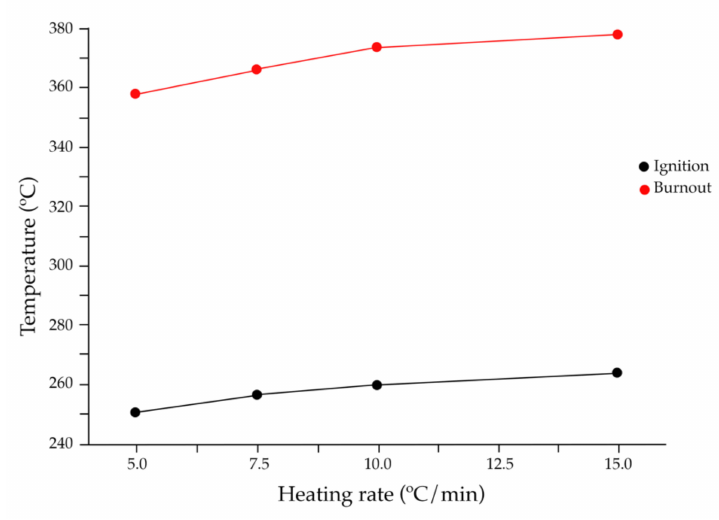
Figure 4. Ignition and burnout temperatures at IM vary according to heating